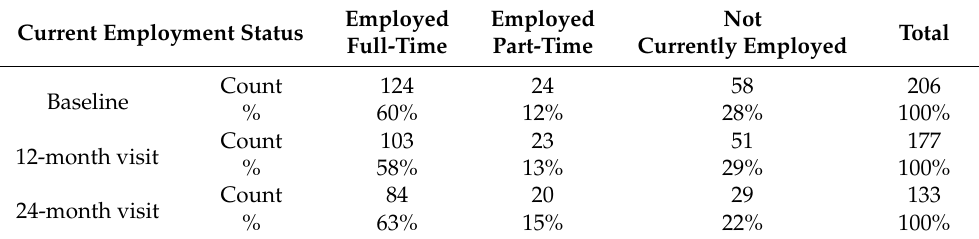
Table 4. Employment status of Teri-REAL patients by